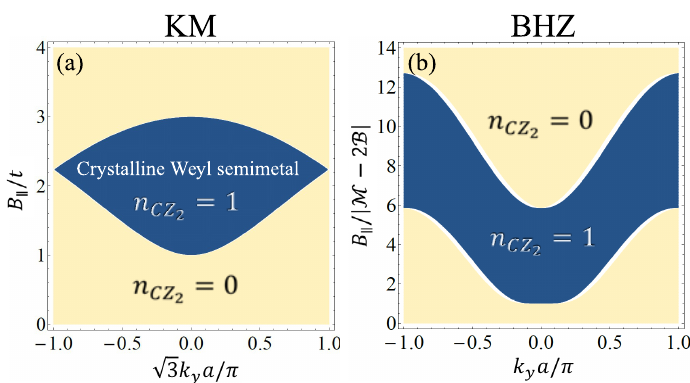
Figure 3: Panels (a) and (b) show the phase diagrams of n and B (cid:107) for the KM and BHZ model, respectively. Blue areas correspond to n = 0. Thus, blue areas show the extension of the Fermi while the yellow areas to n CZ 2 arcs in reciprocal space for a given B (cid:107) . In the BHZ model we used A = 182.25meV, B = 343meV and M =